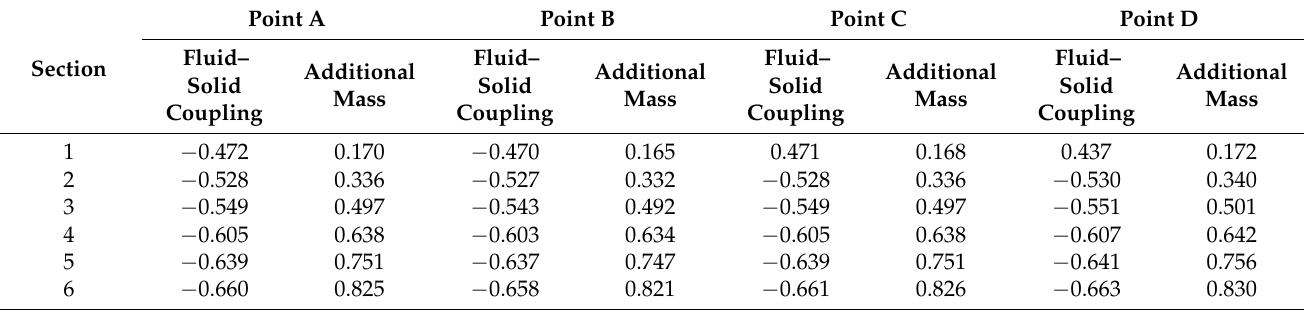
Table 4. Peak of displacement response of different pipeline cross-sections (unit: m) – left platform.